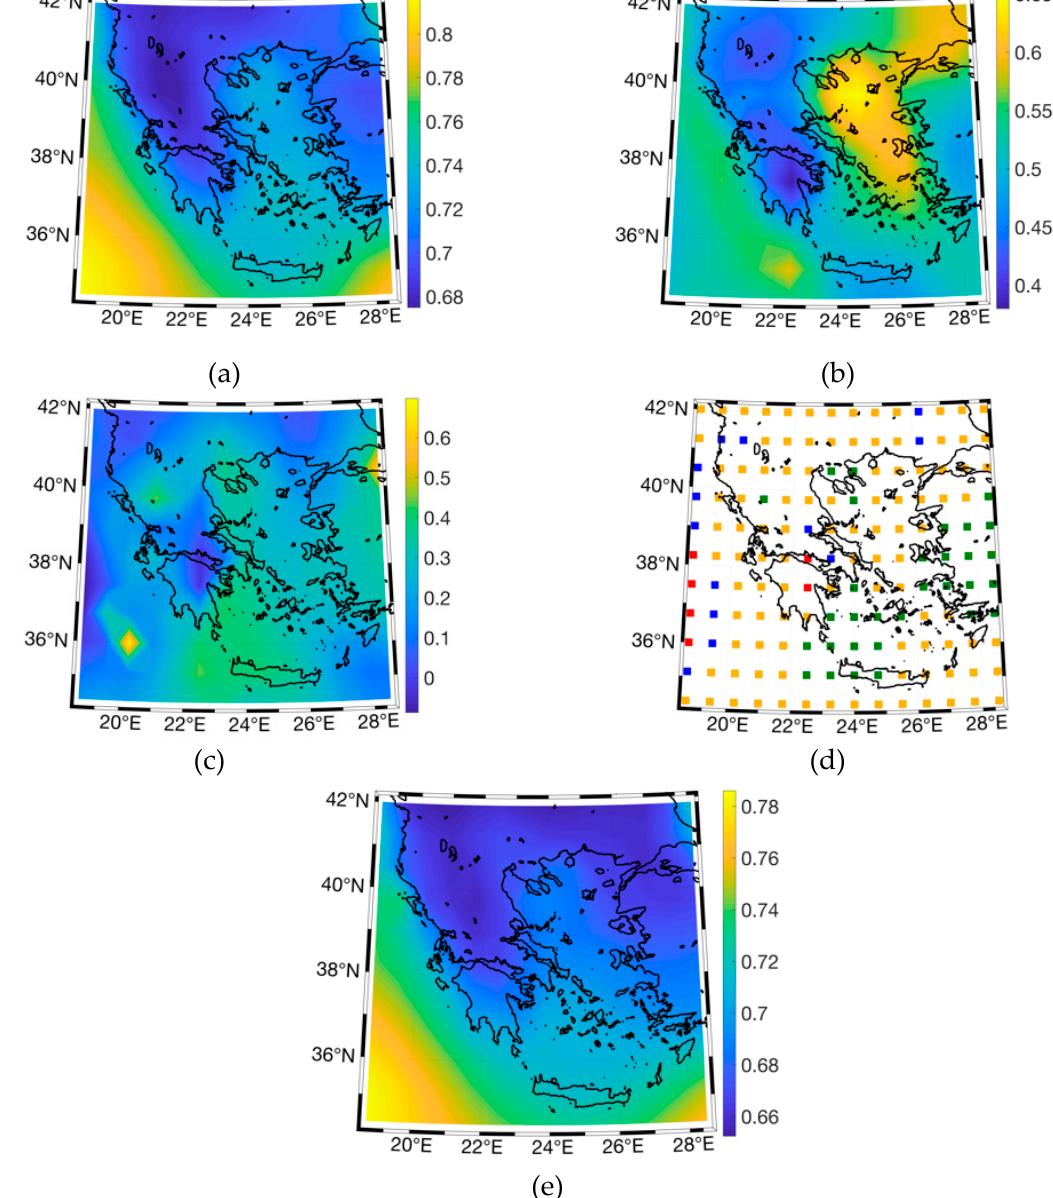
Figure 7. Spatial distribution of a 0 ( a ), spectral width ( b ), asymmetry parameter ( c ), truncation type ( d ) where (LL: green squares, L: orange squares, S: blue squares, and R: red squares), and h(2) ( e ).